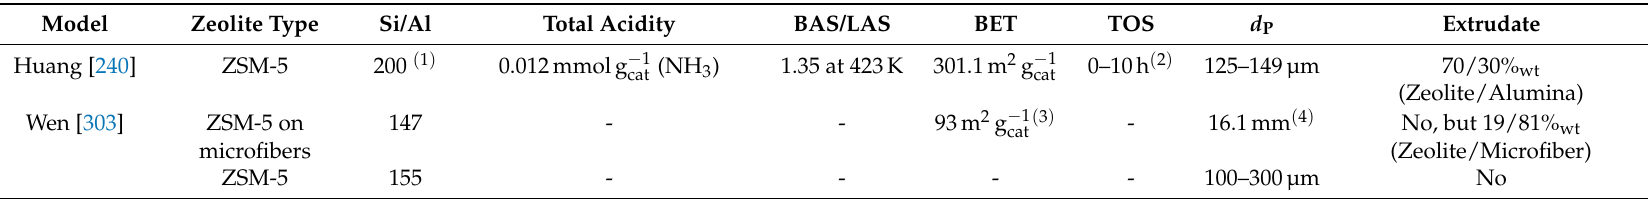
Table 5. Properties of the different catalysts which were used for the kinetic models of methanol-to-olefins with olefin co-feed; besides the zeolite type, its silicon-to-aluminum ratio (Si/Al), its total number of acid sites as well as the determination method, its ratio of Brønsted to Lewis acid sites (BAS/LAS) and its surface area according to the method by Brunauer–Emmett–Teller (BET) are shown. Furthermore, the time-on-stream (TOS) after which the kinetic data were taken, the particle size ( d P ) and the information on whether an extrudate or pure powder was used are presented. A hyphen represents missing information. Model